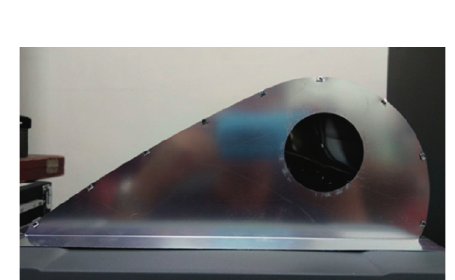
Figure 14: The measured intensity distribution of the optimized CBL with the 400W sodium